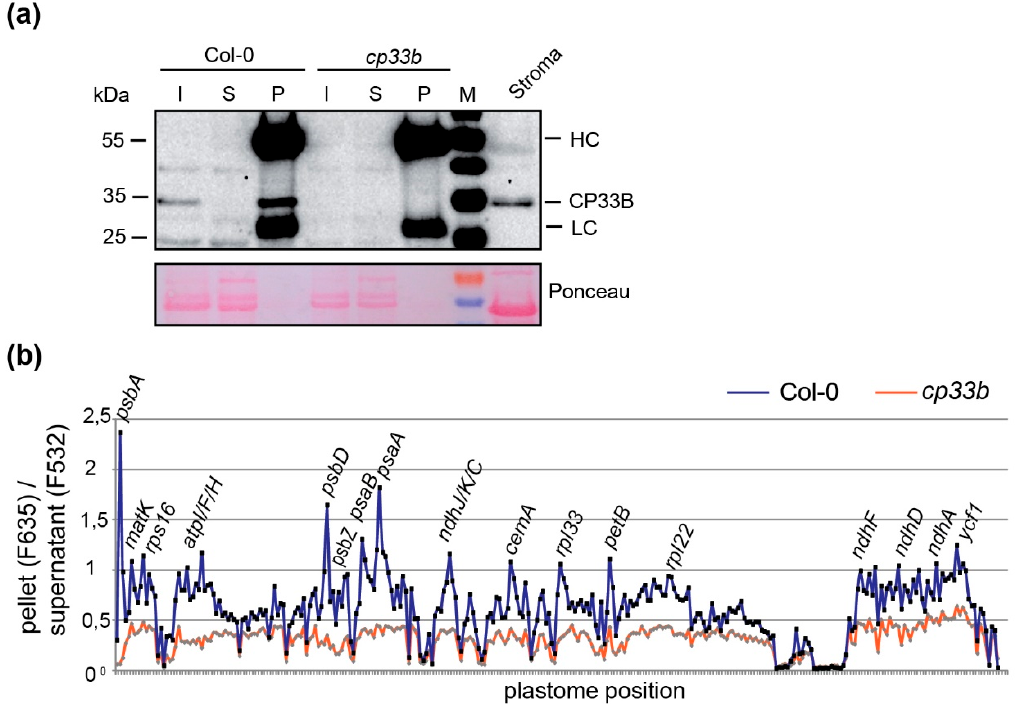
Figure 5. RNAs bound by membrane ‐ localized CP33B. ( a ) Immunoprecipitation of CP33B from membranes. Immunoblot analysis of protein fractions after immunoprecipiation of CP33B from solubilized membranes of wt and cp33b null mutants. Relative to the volume of the input membrane fractions used (I) for the IPs, 1 / 20 of the supernatant (S) and 1 / 10 of the pellet (P) fractions were loaded. An aliquot of wt stroma from the same chloroplast preparation was analyzed as well, which shows the depletion of RuBisCO in the membrane fractions compared to the stroma fraction by Ponceau staining. Bands marked with HC and LC represent the heavy and light chains, respectively, of antibodies used for immunoprecipitation. ( b ) RIP ‐ Chip analysis of membrane ‐ bound CP33B. RNA from pellet and supernatant fractions of CP33B immunoprecipitations and control reactions were analyzed by microarray hybridization analogously to stroma RIP ‐ Chips shown in Figure 3. The pellet/supernatant ratios (median (median of ratios)) were normalized to the sum of the median values of the ribosomal RNAs of the supernatants (median F532; Table S4). Ratios of fluorescence signals from co ‐ precipitated RNA (F635) and unbound RNA (F532) for IPs from wt and cp33b mutant membranes were plotted against the probe positions on the chloroplast genome.